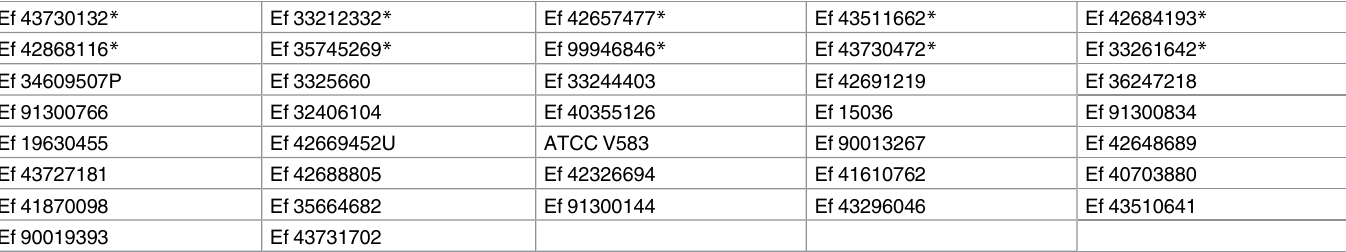
Table 1. E . faecalis strains supplied by the Microbiology and Infectious DiseaseLaboratory, SA Health, South